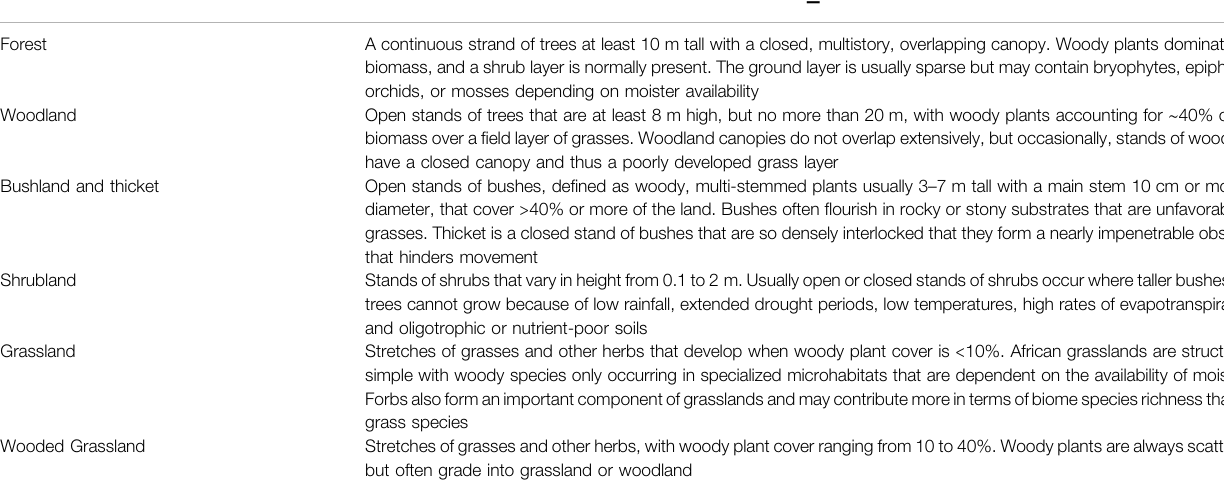
TABLE 1 | Synopsis of main habitat types mentioned in the text. Adopted from White, 1983. — Forest A continuous strand of trees at least 10 m tall with a closed, multistory, overlapping canopy. Woody plants dominate the biomass, and a shrub layer is normally present. The ground layer is usually sparse but may contain bryophytes, epiphytes, orchids, or mosses depending on moister availability